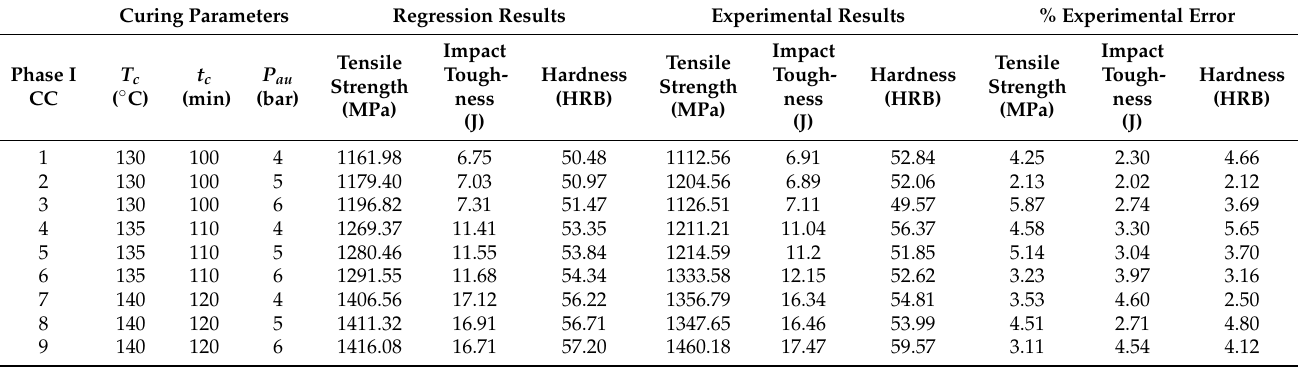
Table A1. Comparison of Phase I experiments result with the regression model. The percentage of experimental error was found between 2.02 to 5.87%, which is an acceptable